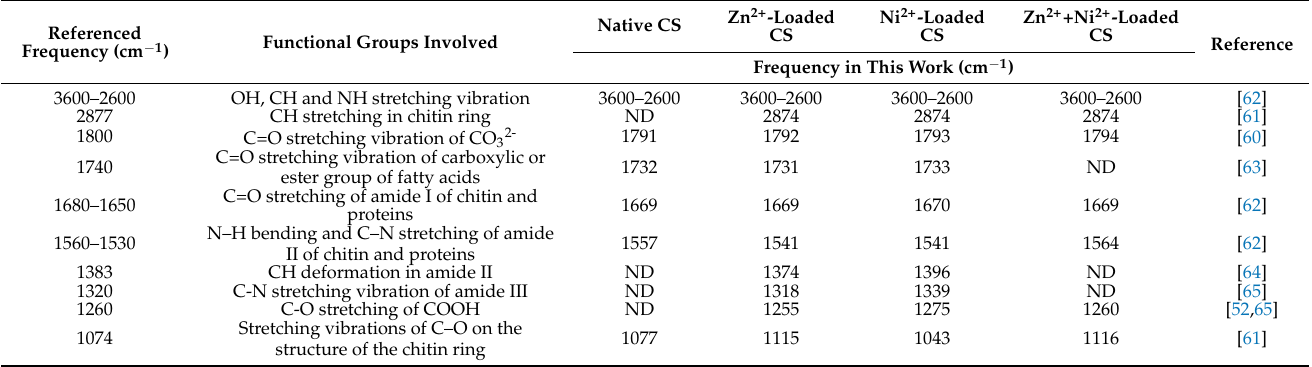
Table 5. Main vibration frequencies found in the DRIFTS spectra of the native CS and the CS loaded with Zn 2+ , Ni 2+ , and Zn 2+ +Ni 2+